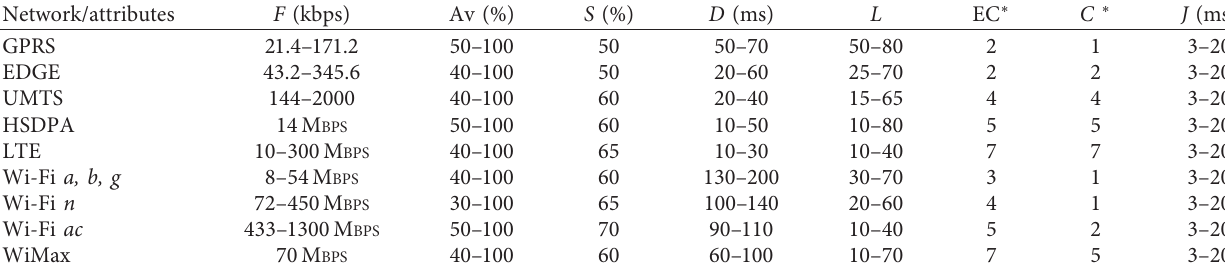
Table 3: Values of attributes used in the simulation of MADM methods.